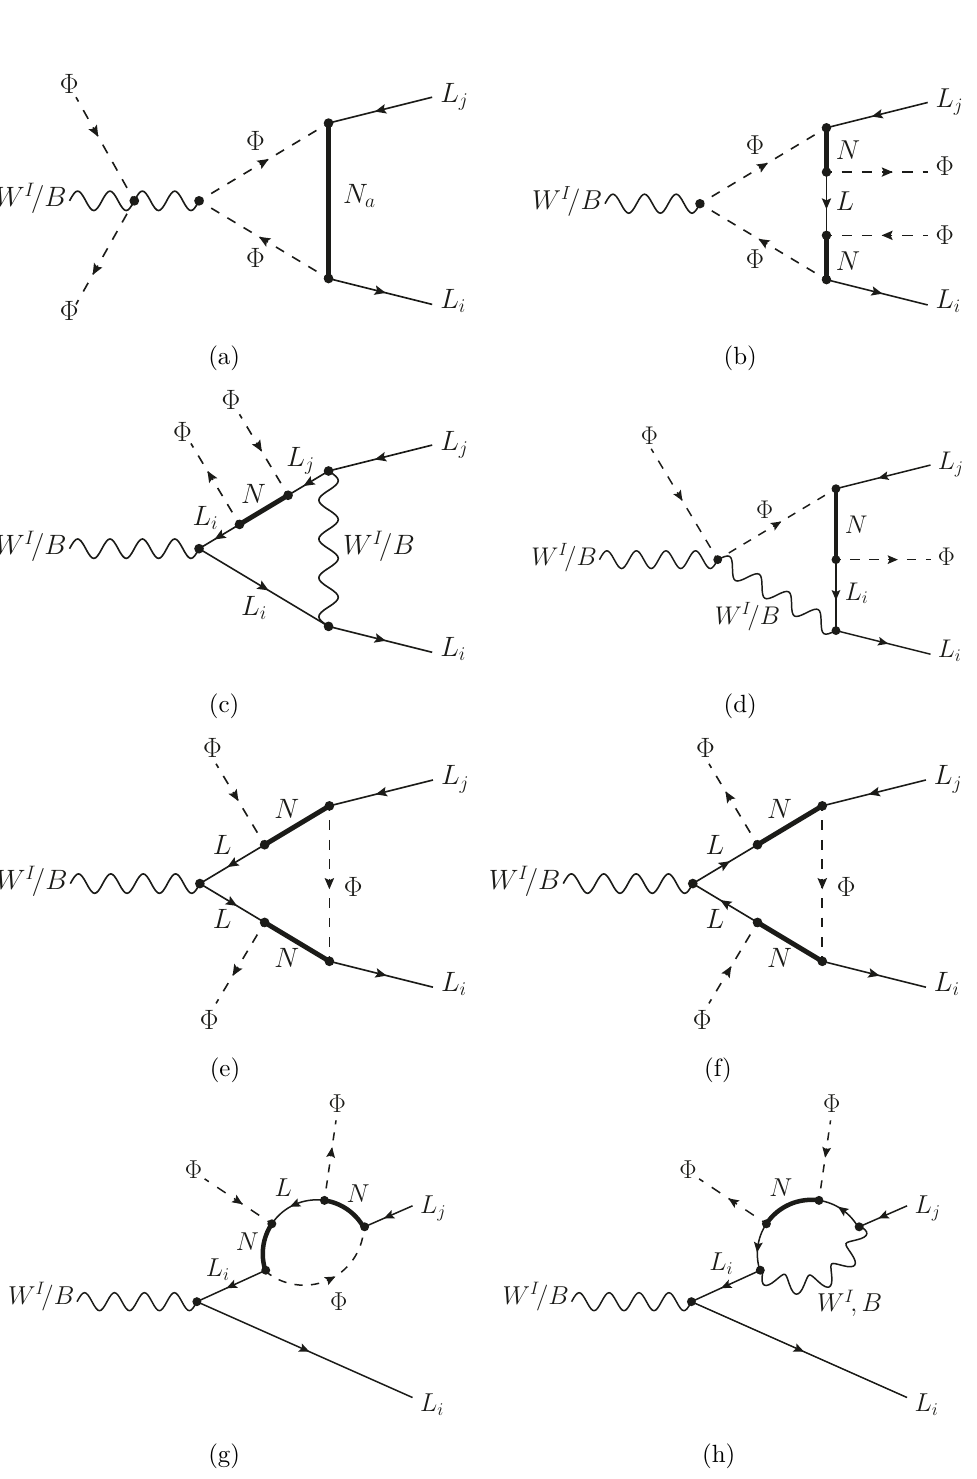
Figure 4. Diagrams contributing to the 1-loop matching onto O (1) equivalently, onto O + and O −